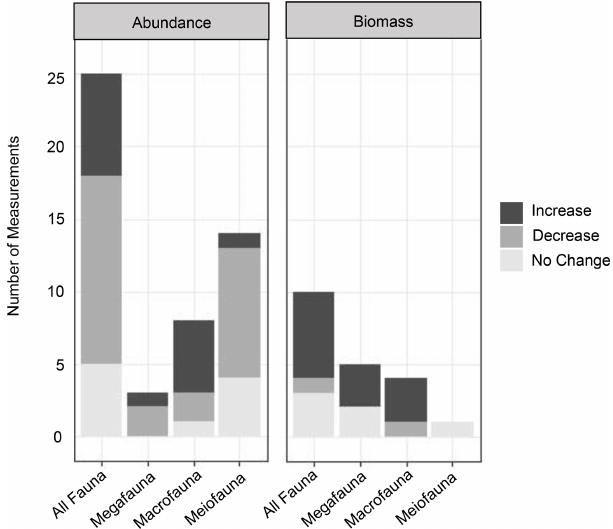
Figure 4. Graphs of the impacts of turbidity flows on the biomass and abundance (proxies of productivity) of benthic communities in three size classes (mega-, macro-, and meiofauna) and a summary group of all size classes (“All Fauna”). Increase, decrease, or no change in abundance or biomass in turbidite-affected areas was as- sessed by comparing individual measurements of these productivity metrics at different sites in the studies listed in Table